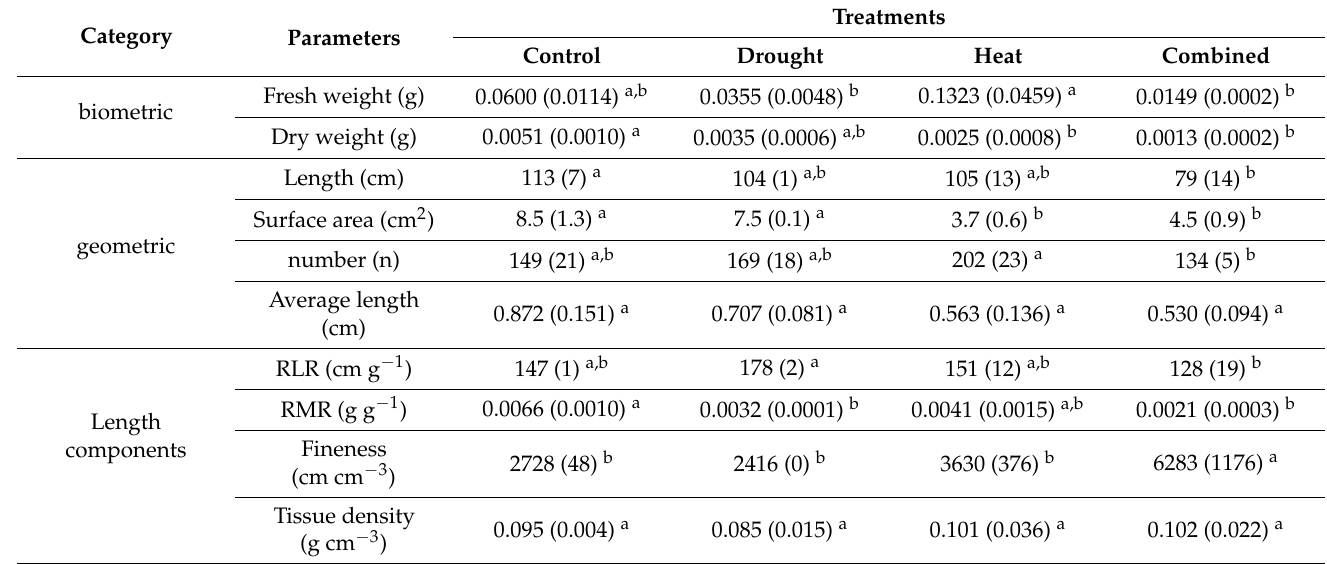
Table 4. Morphology of seminal lateral roots of maize plants exposed to single (drought and heat) and combined stress (drought +